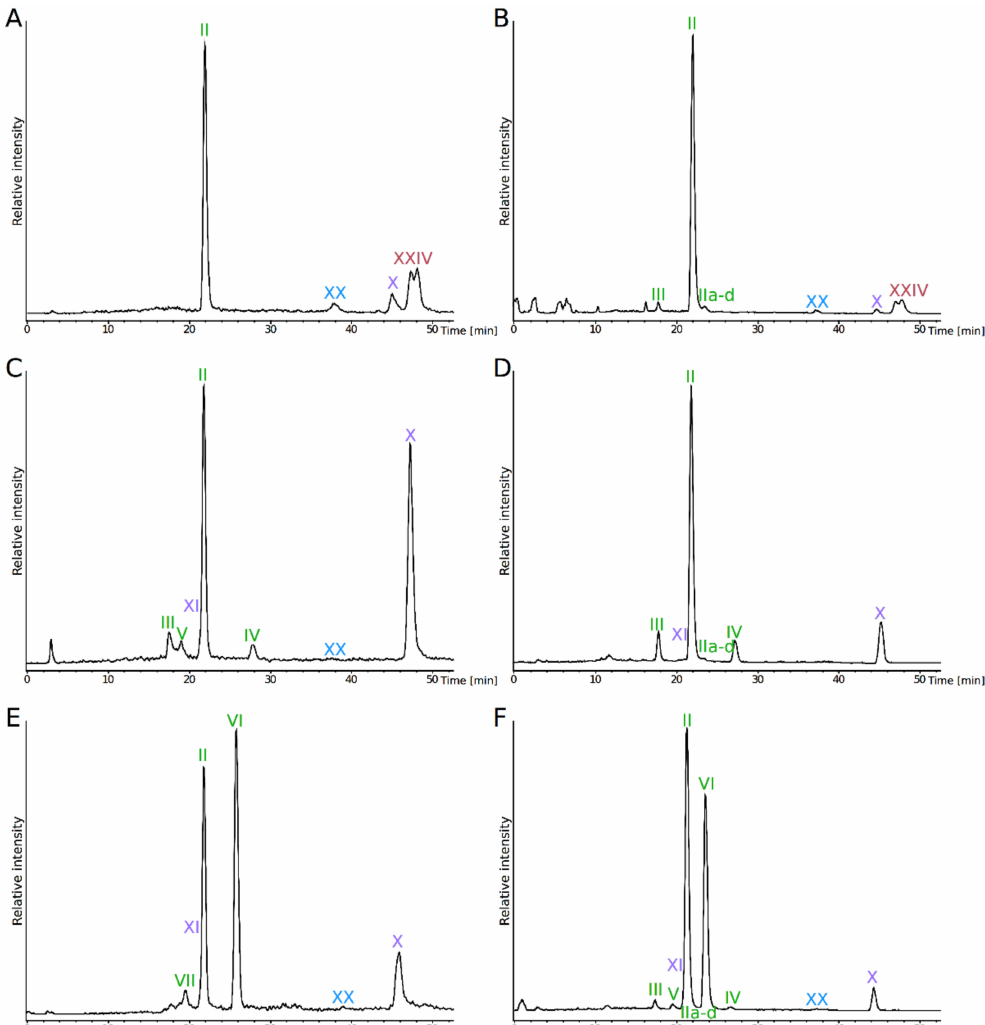
Figure 2. HPLC-ESI-MS chromatograms of intact polar lipids of Pyrococcus furiosus ( A , B ), P. yayanosii ( C , D ) and Thermococcus kodakarensis ( E , F ). Intact polar lipids were detected in positive ( A , C and E ) and negative ( B , D and F ) ion modes. Chromatograms were drawn by extracting the following protonated and deprotonated ions: positive mode: 893, 894, 895, 936, 1056, 1057, 1124, 1125, 1544, 1784, 1786 and 1788; negative mode: 881, 883, 889, 891, 892, 893, 934, 1054, 1055, 1122, 1123, 1542, 1782, 1784, and 1786. Refer to Figure 1 for lipid structures and their corresponding